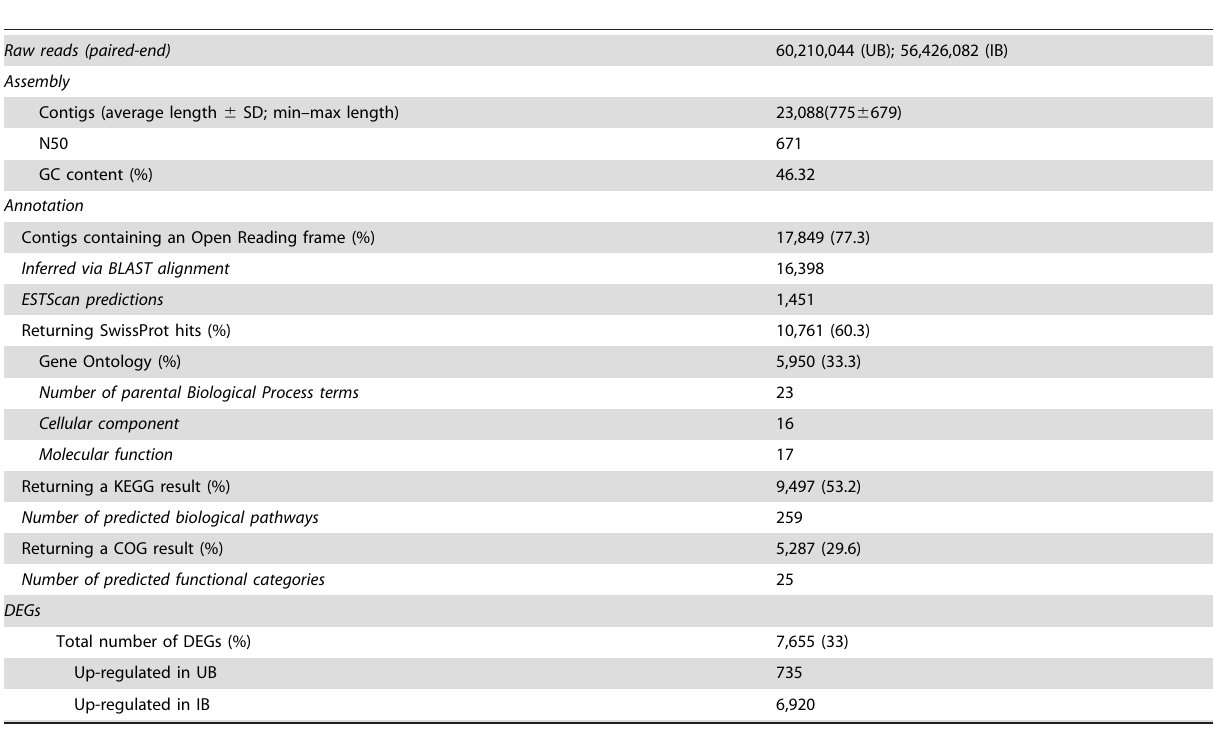
Table 1. Summary of the RNA-Seq data from uninfected and Opisthorchis viverrini -infected Bithynia siamensis goniomphalos snails (UB and IB, respectively), prior and following assembly, and results of bioinformatic analyses and annotation.